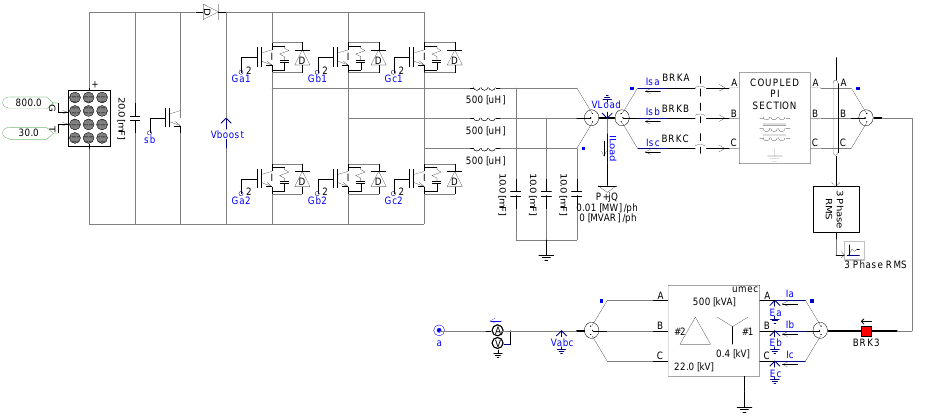
Figure 11. The single line diagram of a PV rooftop system with a 500 kVA transformer and a light load connected.